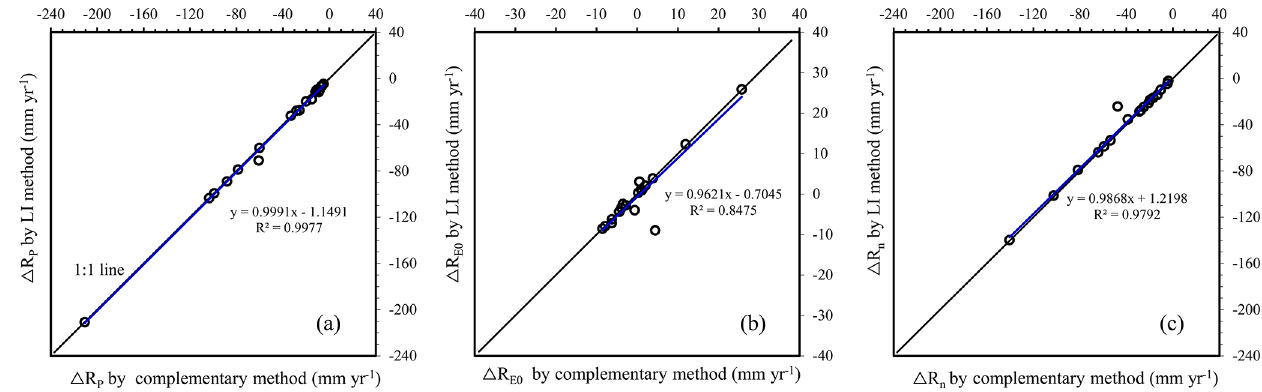
Figure 6. Comparisons of (a) (cid:49)R P , (b) (cid:49)R E